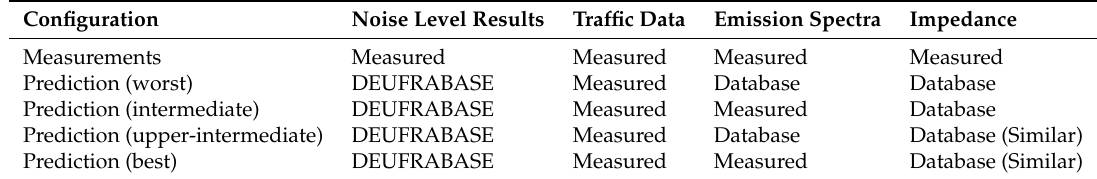
Table 7. Selected configurations for validation. Using the DEUFRABASE, several options are possible to evaluate the noise impact of a road configuration, depending on the nature of the input data. Input parameters can the one that are ‘measured’ or the one specified by the ‘database’. Speed correction, presented at Section 3.3.2, was applied on the DEUFRABASE results when necessary. Configuration Noise Level Results Traffic Data Emission